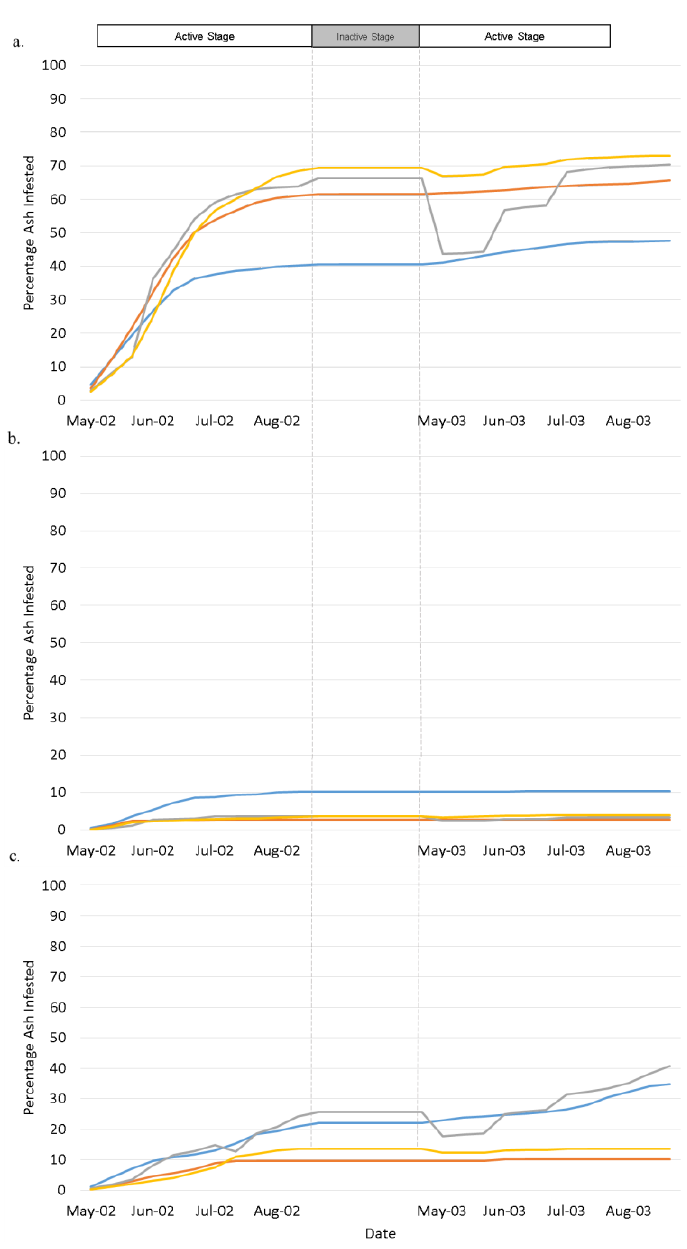
Figure 7. Graphs representing the percentage of all ash trees infested for: ( a ) Urban Landscape; ( b ) Rural-Urban Fringe Landscape; and ( c ) Rural Landscape scenarios.